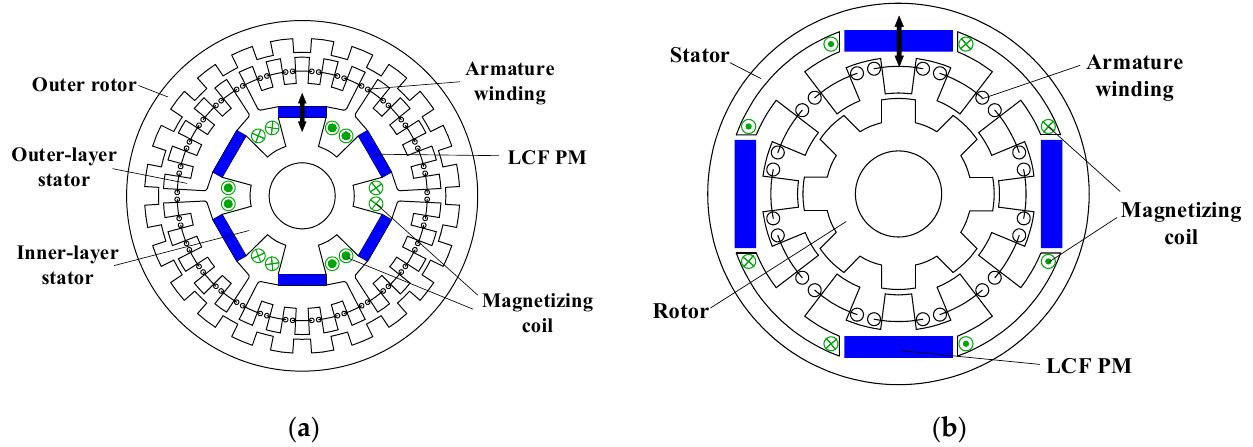
Figure 35. Multi ‐ phase doubly salient VFM machine. ( a ) Topology decomposition diagrams [92]. ( b ) Inner rotor topology [96].